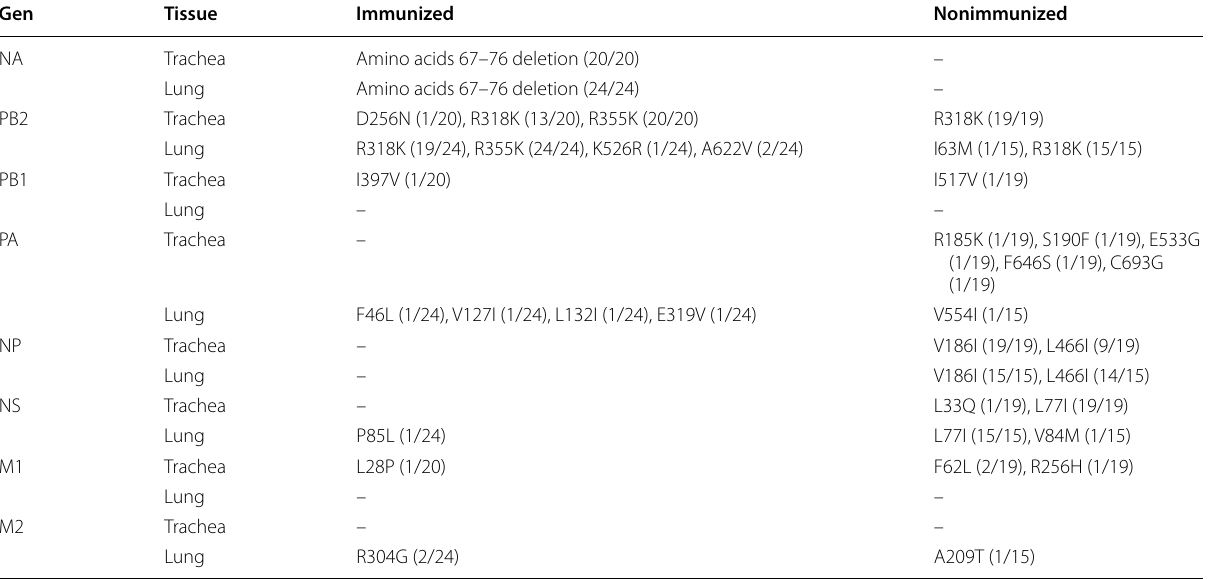
Table 5 List of mutations of the genes other than HA in progeny strains